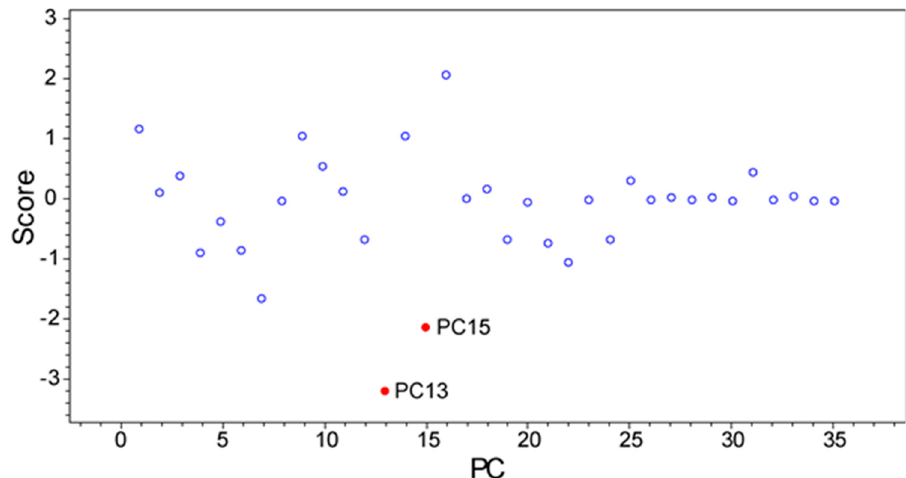
Figure 2. A scores overview plot for strain WMMB-499 in dataset one. To view the unique molecules associated with WMMB-499, PC13 versus PC15 would provide the greatest separation from the other strains in this analysis because the absolute value of the score difference is the greatest.